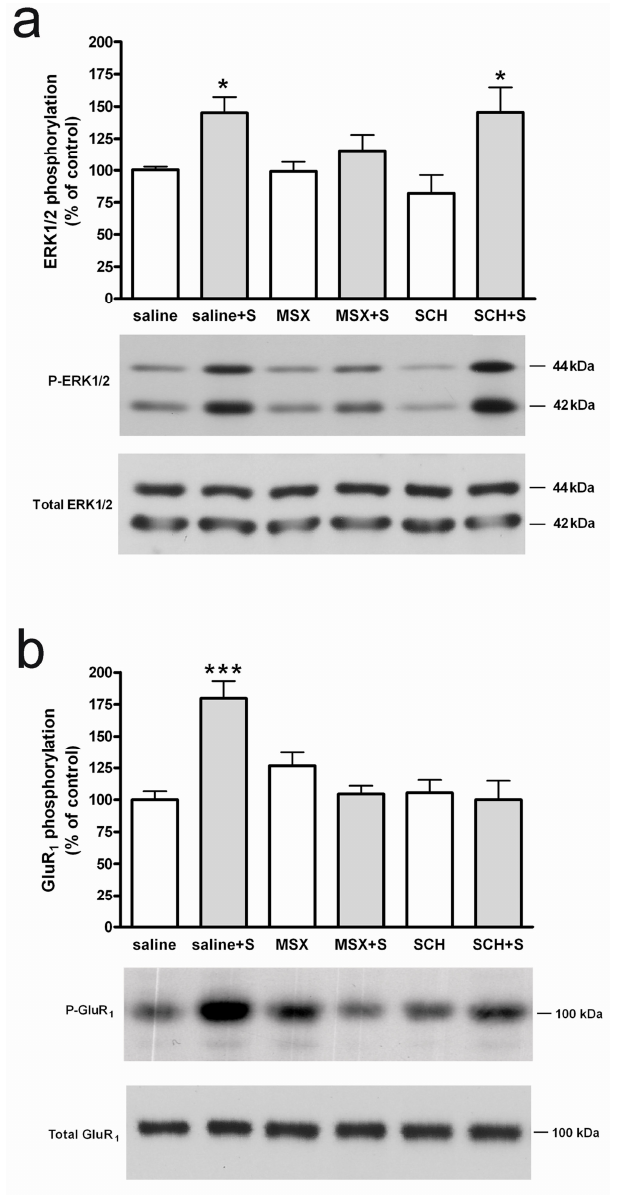
FIGURE 9. A 2A receptor antagonist–induced blockade of the striatal protein phosphorylation induced by cortical electrical stimulation. (a) The A 2A receptor antagonist MSX-3 (3 mg/kg), but not the D 1 receptor antagonist SCH23390 (0.3 mg/kg), counteracted striatal ERK1/2 phosphorylation induced by cortical stimulation. (b) Both MSX-3 and SCH23390 counteracted striatal PKA-dependent phosphorylation of GluR 1 subunit of AMPA receptor. Results are shown in means ± SEM (n = 6–13 per group) and representative Western blots. *, ***: significantly different compared to saline-treated group ( p < 0.05 and p < 0.001, respectively). “S” refers to cortical